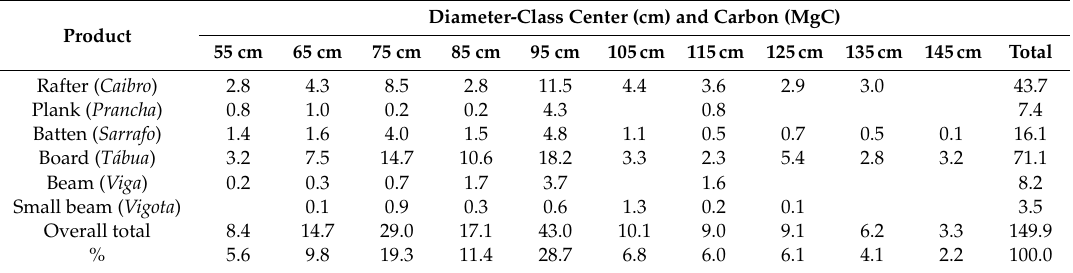
Table 6. Carbon (MgC) distribution by diameter class (cm) in sawmill-derived products from logs in a 1252.8-ha area harvested in a forest-management area in the state of Acre, Brazil.